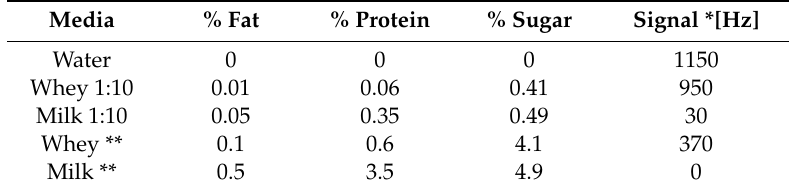
Table 1. Sensor responses in di ff erent sample matrices at a constant melamine concentration of 3200 mg / L.